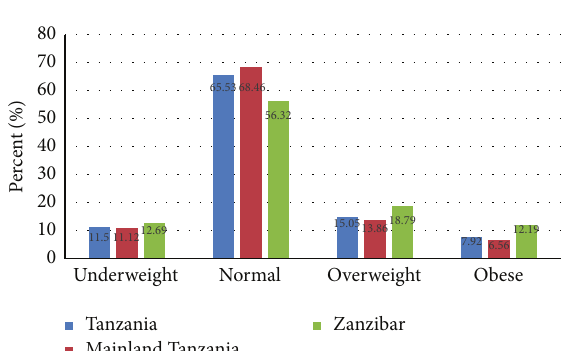
Figure 1: Overweight and obesity prevalence among nonpregnant women in